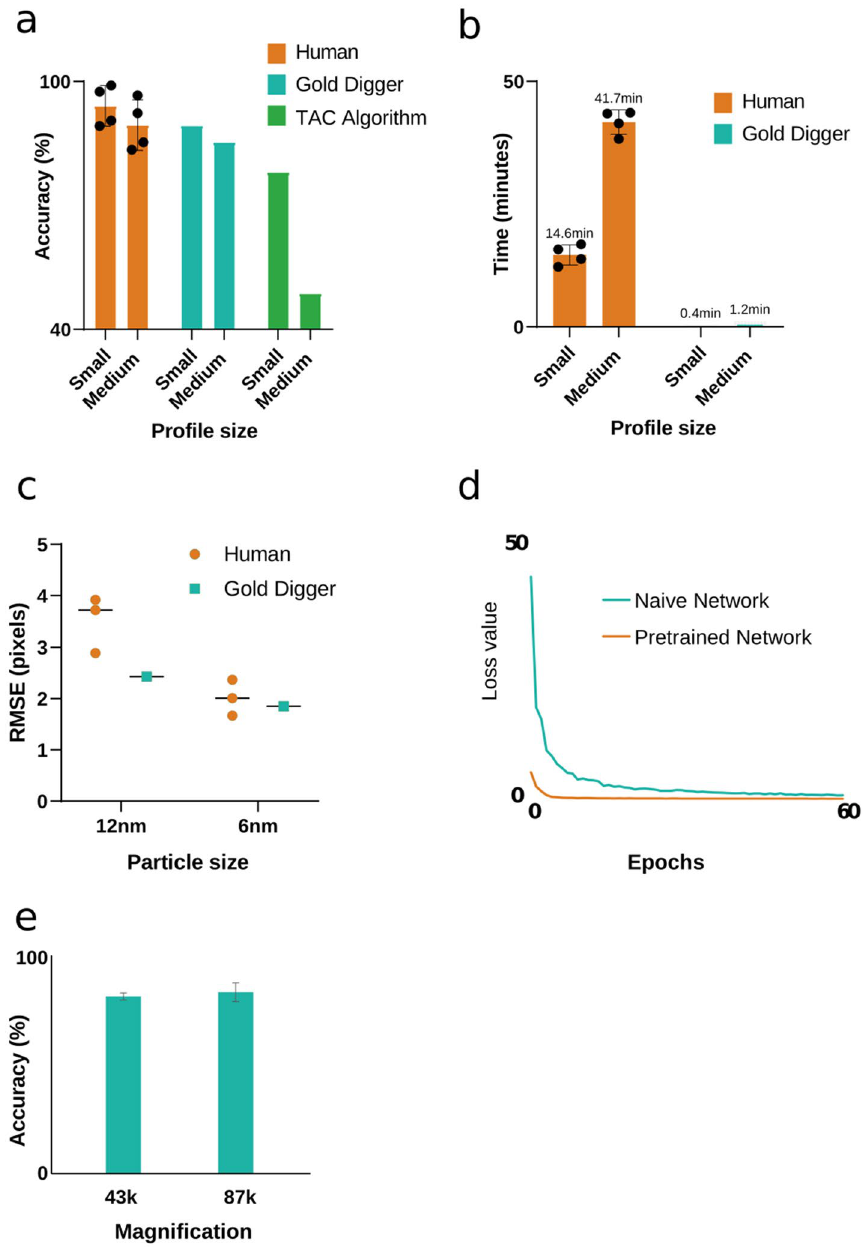
Figure 4. Gold digger performance. ( a ) Gold Digger accuracy vs human and TAC algorithm. Accuracy is calculated by true positives annotated within the p-face of the profile size divided by the total number of gold particles as determined by the ground truth. 100% accuracy was defined by expert annotation. Annotated profiles were collected from trained individuals (n = 4). ( b ) Time required for annotation. Time for manual annotation was gathered by 4 individuals who all had prior immunogold labelling experience. Gold Digger was applied to the dataset locally on a machine equipped with a NVidia GeForce GTX 1080ti. Different computer specifications may lengthen or shorten this time. ( c ) Annotation variability, represented as root mean square error, in Gold Digger compared to humans. ( d ) The pretrained network was trained on the UTZappos-50 k dataset for 200 epochs. ( e ) Gold Digger accuracy relative to original imaging magnification, n =